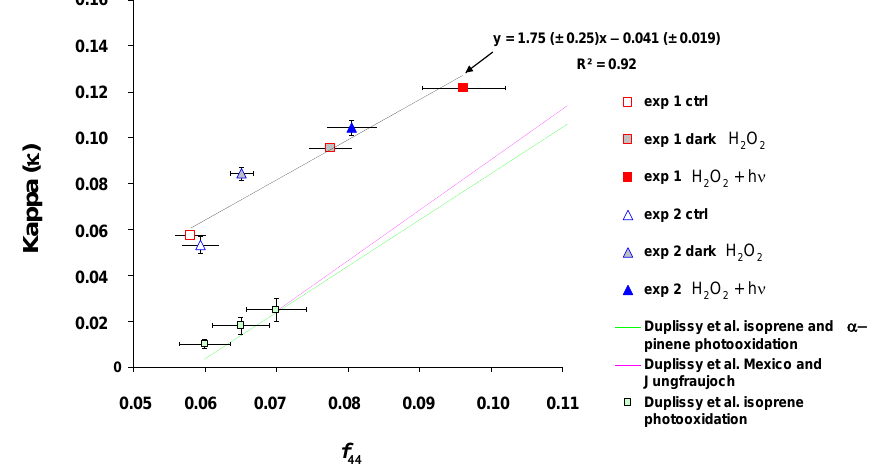
Fig. 4. Relationship between f 44 (obtained from HR-AMS measurements) and κ (obtained from H-TDMA measurements) for experiments 1 and 2 during nebulization of “control”, “dark H 2 O 2 ” and “H 2 O 2 + hν ” samples, obtained after aqueous phase processing of SOA formed from isoprene photooxidation. Comparisons with previous smog chamber and field data obtained by Duplissy et al. (2011). Error bars are the same as those indicated in Figs. 2 and 3.